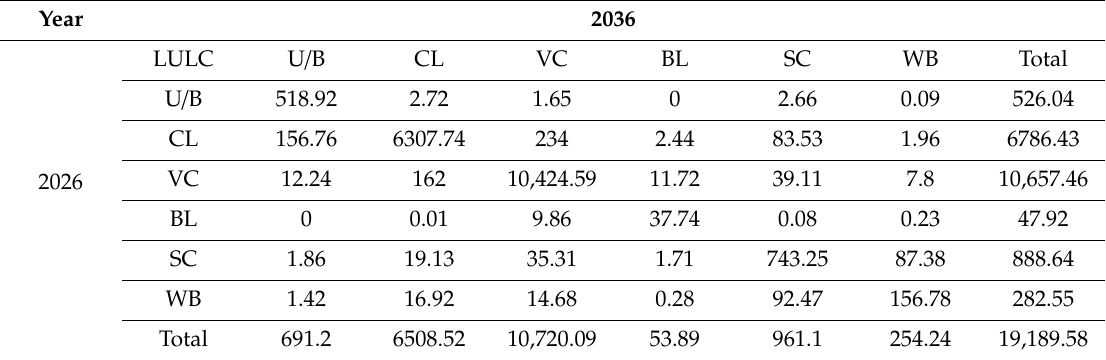
Table 5. LULC transitions during 2026–2036 (in km 2